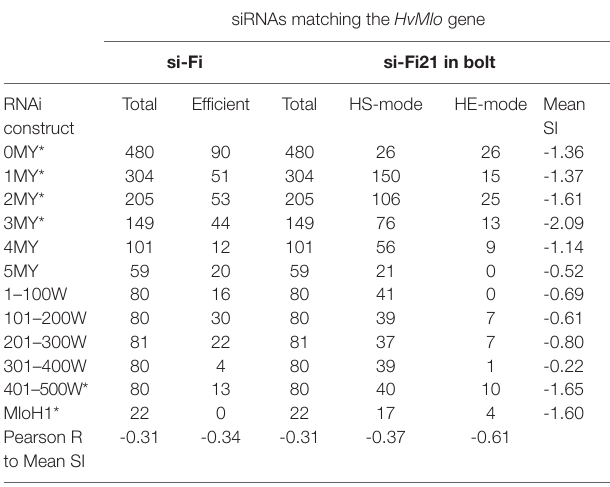
TABLE 2 | Summary of the prediction results of the previous version of si-Fi and the new si-Fi21 in